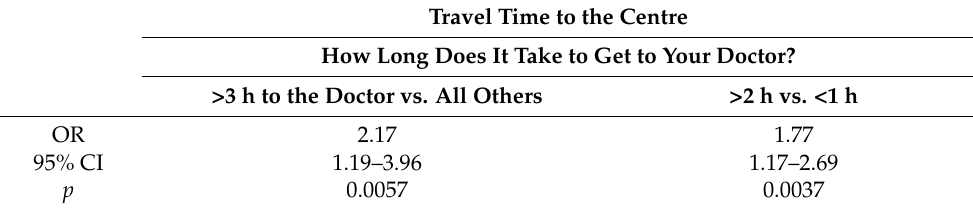
Table 3. The impact of travel time for a medical visit before the pandemic on satisfaction with remote visits. Travel Time to the Centre How Long Does It Take to Get to Your Doctor?